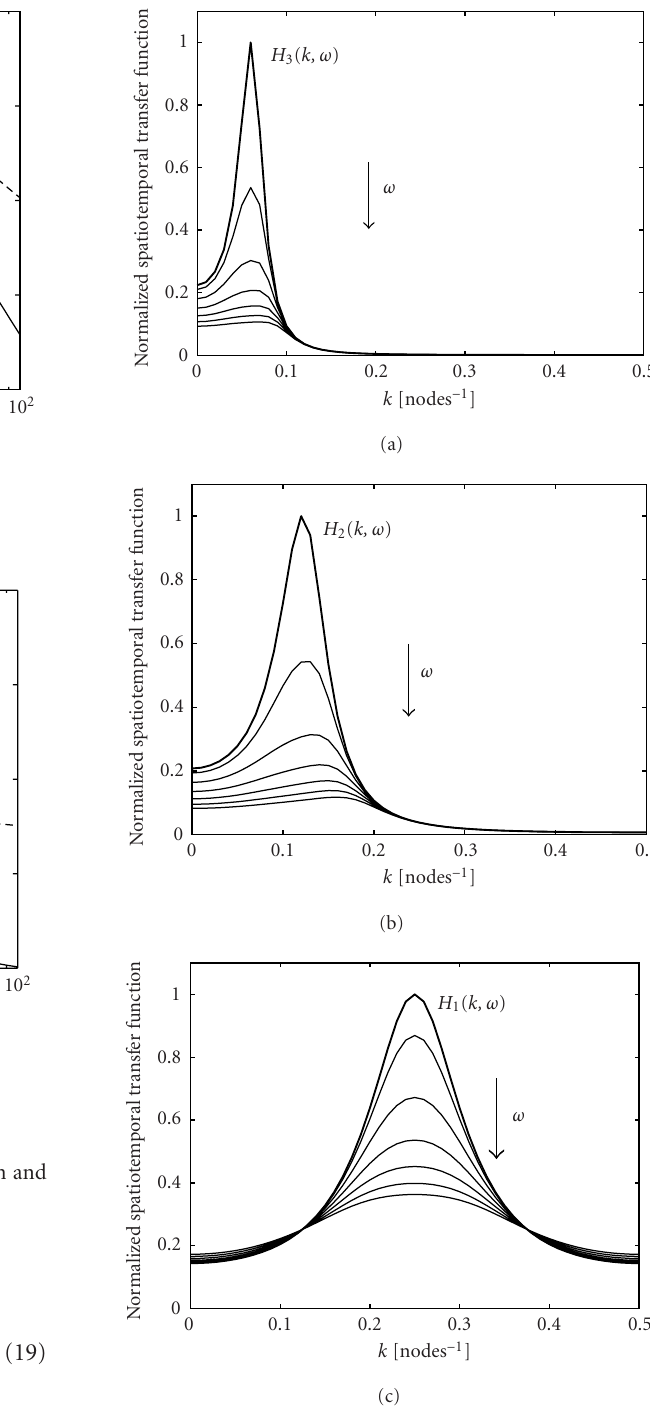
Figure 6: The intrinsic spatiotemporal transfer function of the analog lattice networks implementing Gabor-like spatial filters, de- signed for bandpass spatial operation; the three considered types of filters are those introduced in Figures 4d and 4e. The curves, normalized to the peak value of the static transfer function and parametrized with respect to the temporal frequency ω , describe how the spatial filtering is modified when the input stimulus varies with